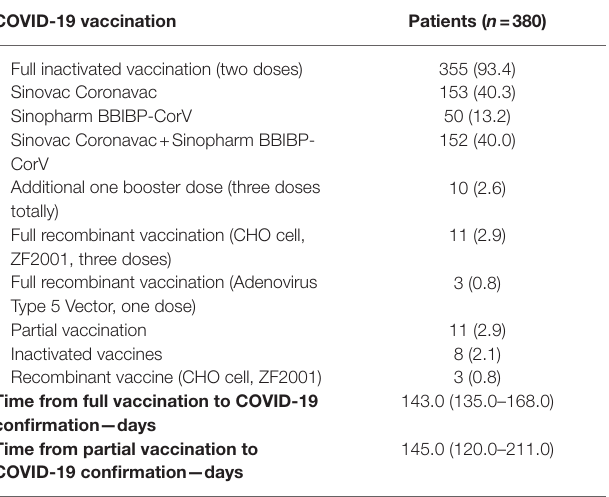
TABLE 1 | Vaccination characteristics of patients upon admission. COVID-19 vaccination